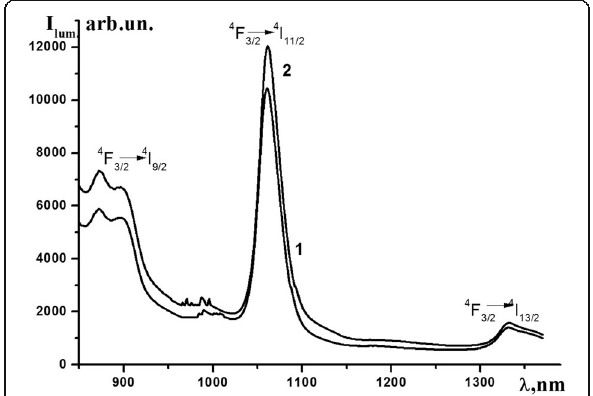
Fig. 7 Emission spectra of [Nd(mphpd) 3 ] n in solution ( 1 ) and powder ( 2 ), λ ex =362 nm, T = 25